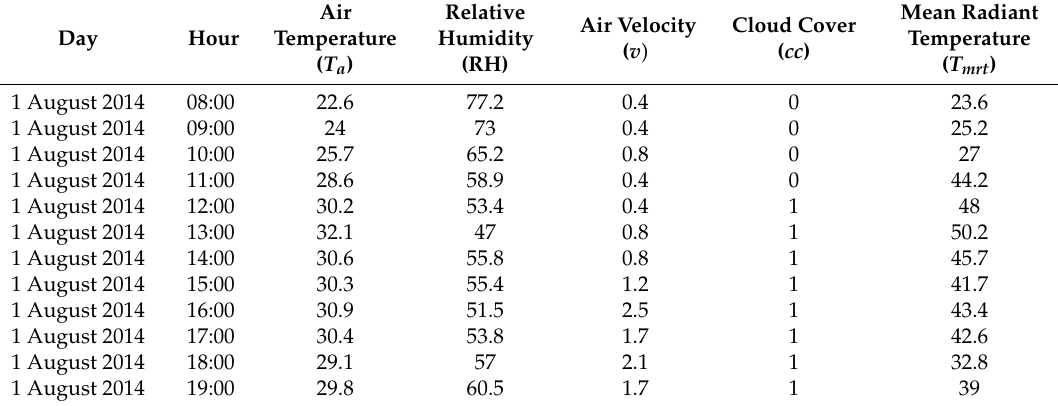
Table 3. Summary of the meteorological parameters measured in the square and collected from the Collegio Romano meteorological station on the 1st and 2nd of August 2014: air temperature ( T a ), air velocity ( v ), relative humidity (RH) and cloud cover ( cc ), and the Mean Radiant Temperature ( T mrt ) calculated with the Rayman